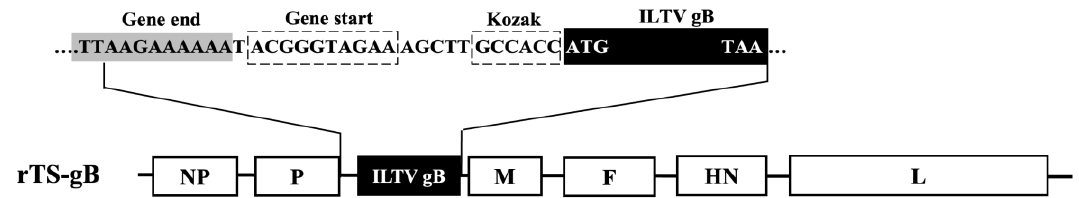
Figure 1. Schematic representation of the genome of the rNDV strain rTS-gB. The gB gene of ILTV was inserted into the genome of NDV TS09-C between the P and M genes. The NDV gene end and gene start signal sequences, Kozak sequences, and ILTV-gB gene were boxed.